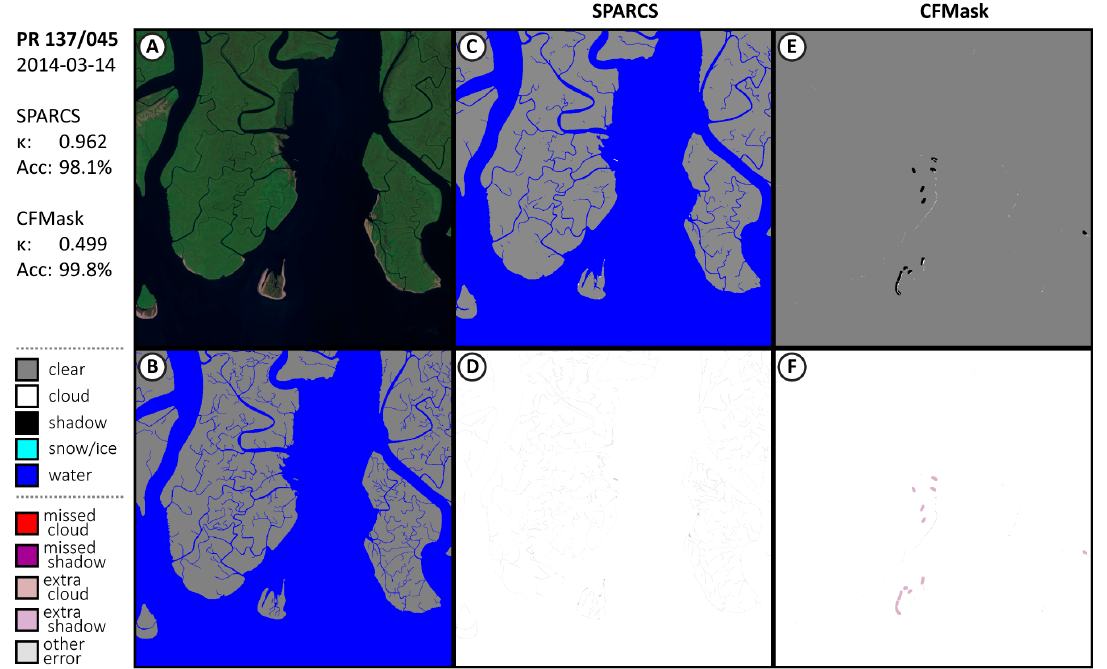
Figure A4. Results for validation test image PR 137/045, with false color image used during interpretation (A), the manually labeled interpretation (B), generated masks from SPARCS (C) and CFMask (E), and respective spatial distribution of errors (D, F).